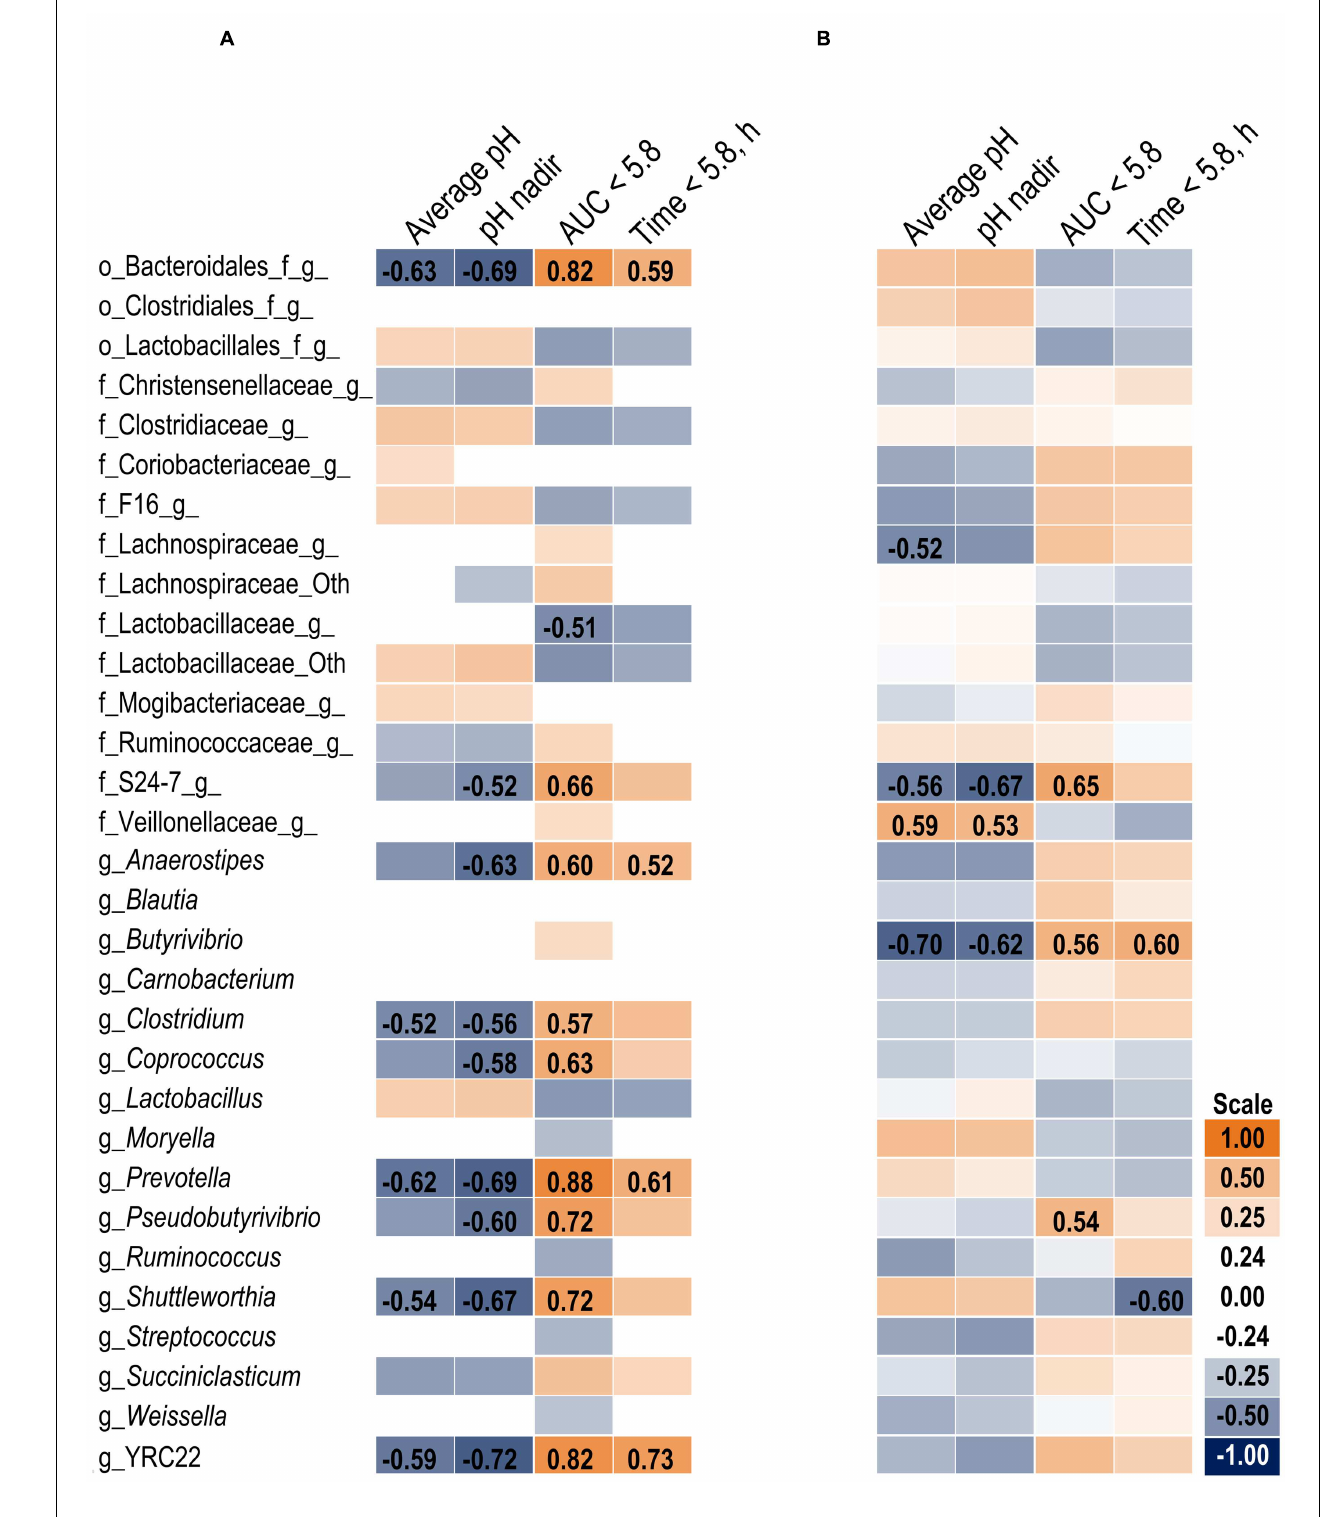
Frontiers in Microbiology |